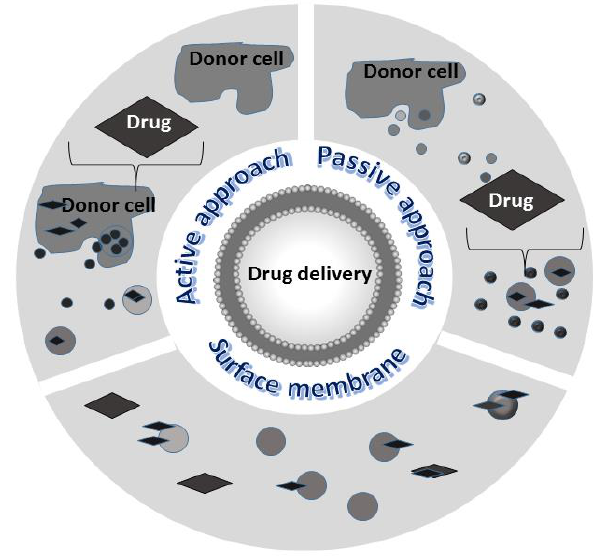
Figure 6. Main strategies for loading exosomes with non-native cargos: cellular modifications or direct vesicle modifications can generate enhanced exosomes to be used as delivery